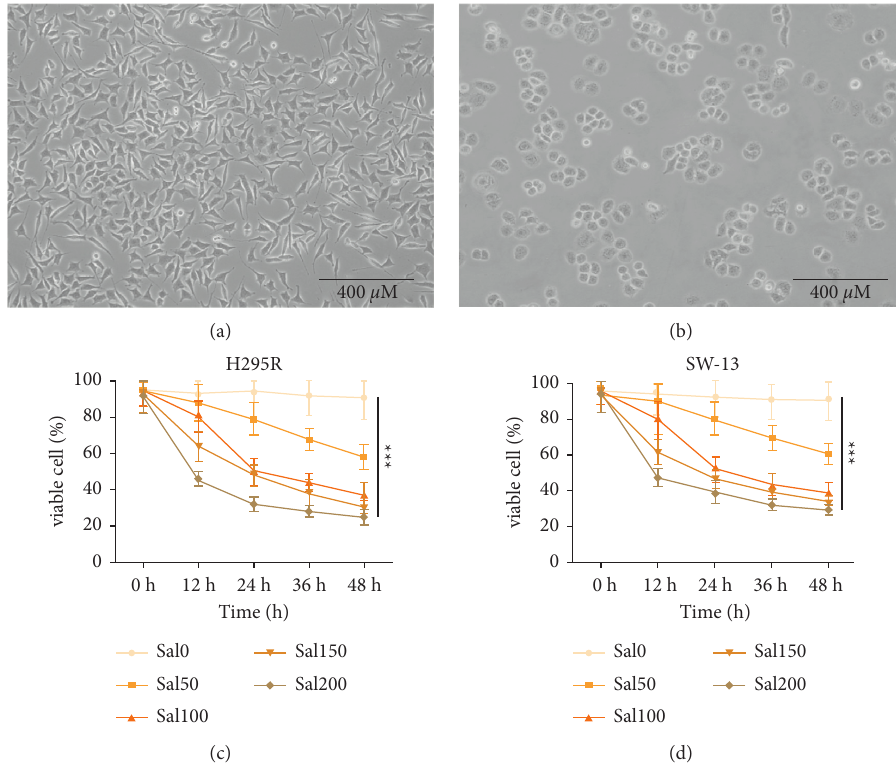
Figure 1: Cell line identification and the effect of Sal on the viability of ACC cells. (a, b) The cellular morphology of ACC NCI–H295R and SW-13 cells (10 × , scale bar is 400 μ m). (c, d) H295R and SW-13 cells were cultured with Sal at concentrations of 0, 50, 100, 150, and 200 μ m for 0, 12, 24, 36, and 48 h. Each experiment was repeated at least 3 times. ∗∗∗ p < 0 .